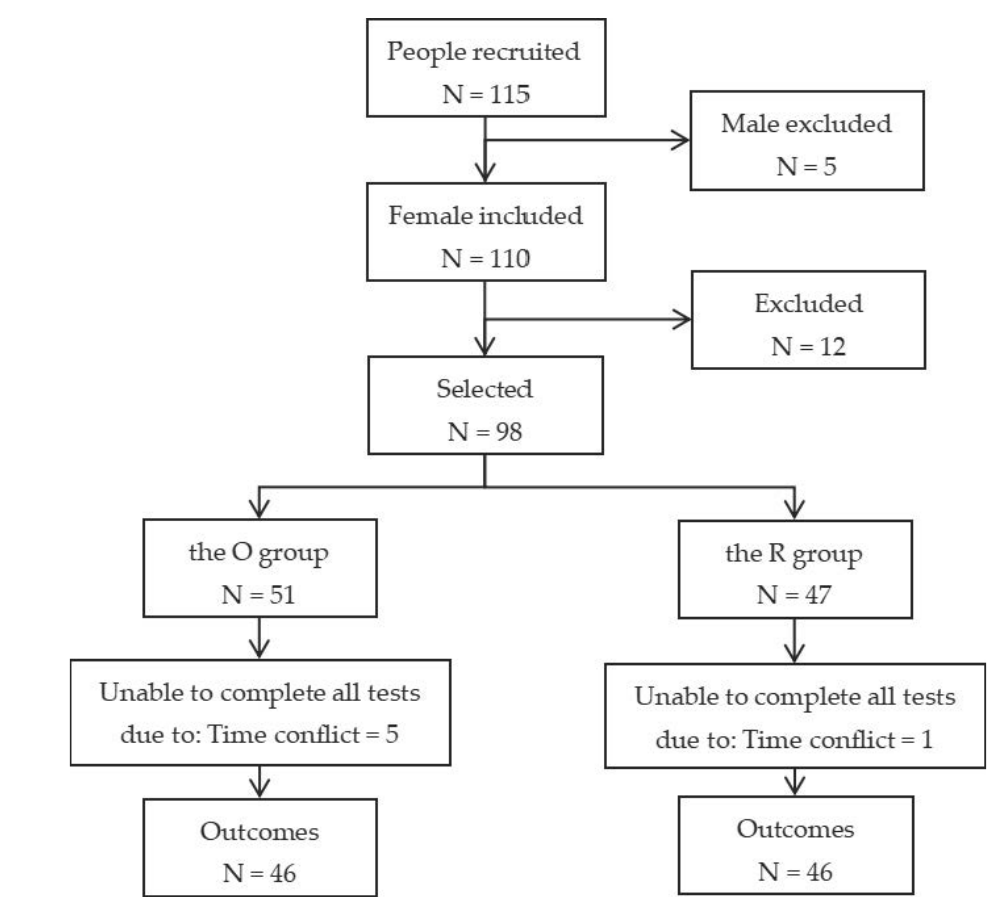
Figure 1. Flowchart explaining the assignment of the participants to O and the R